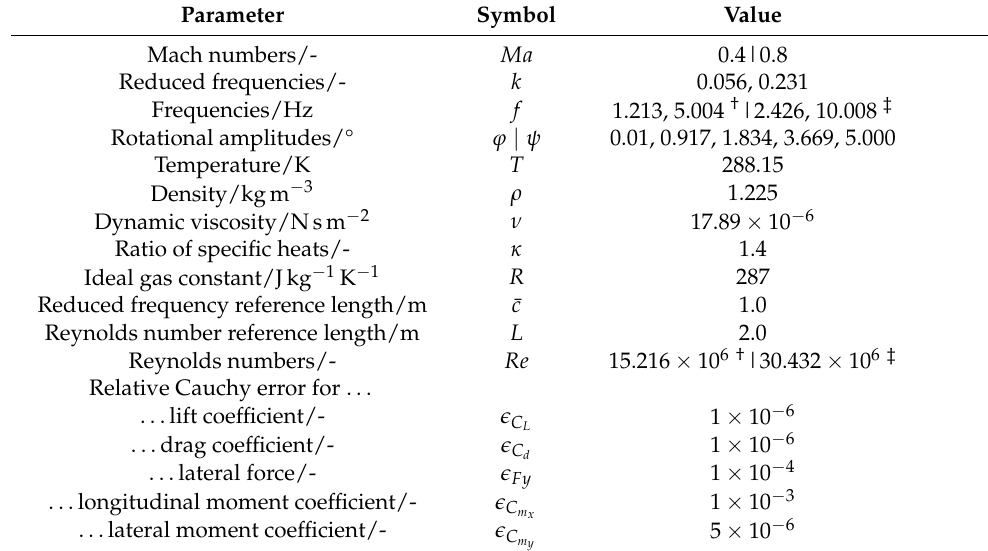
Table 1. Simulation